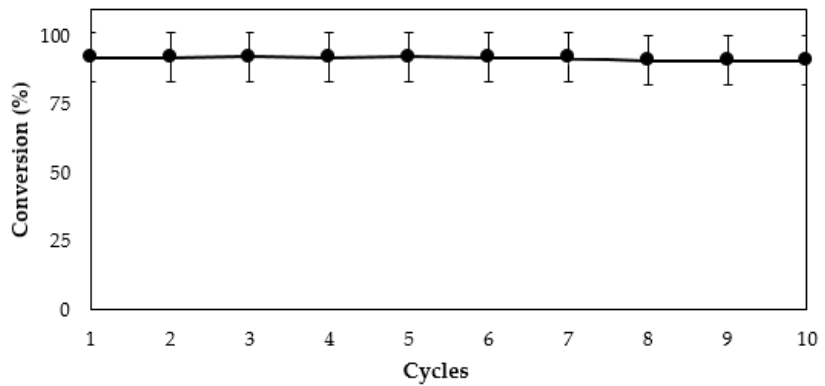
Figure 4. Cycles of activity of Novozym ® 435 in the enzymatic esterification of babassu free fatty acids at 48 ºC, molar ratio 1:18 (FFAs/alcohol), biocatalyst content 0.14 g and 4 h of reaction.